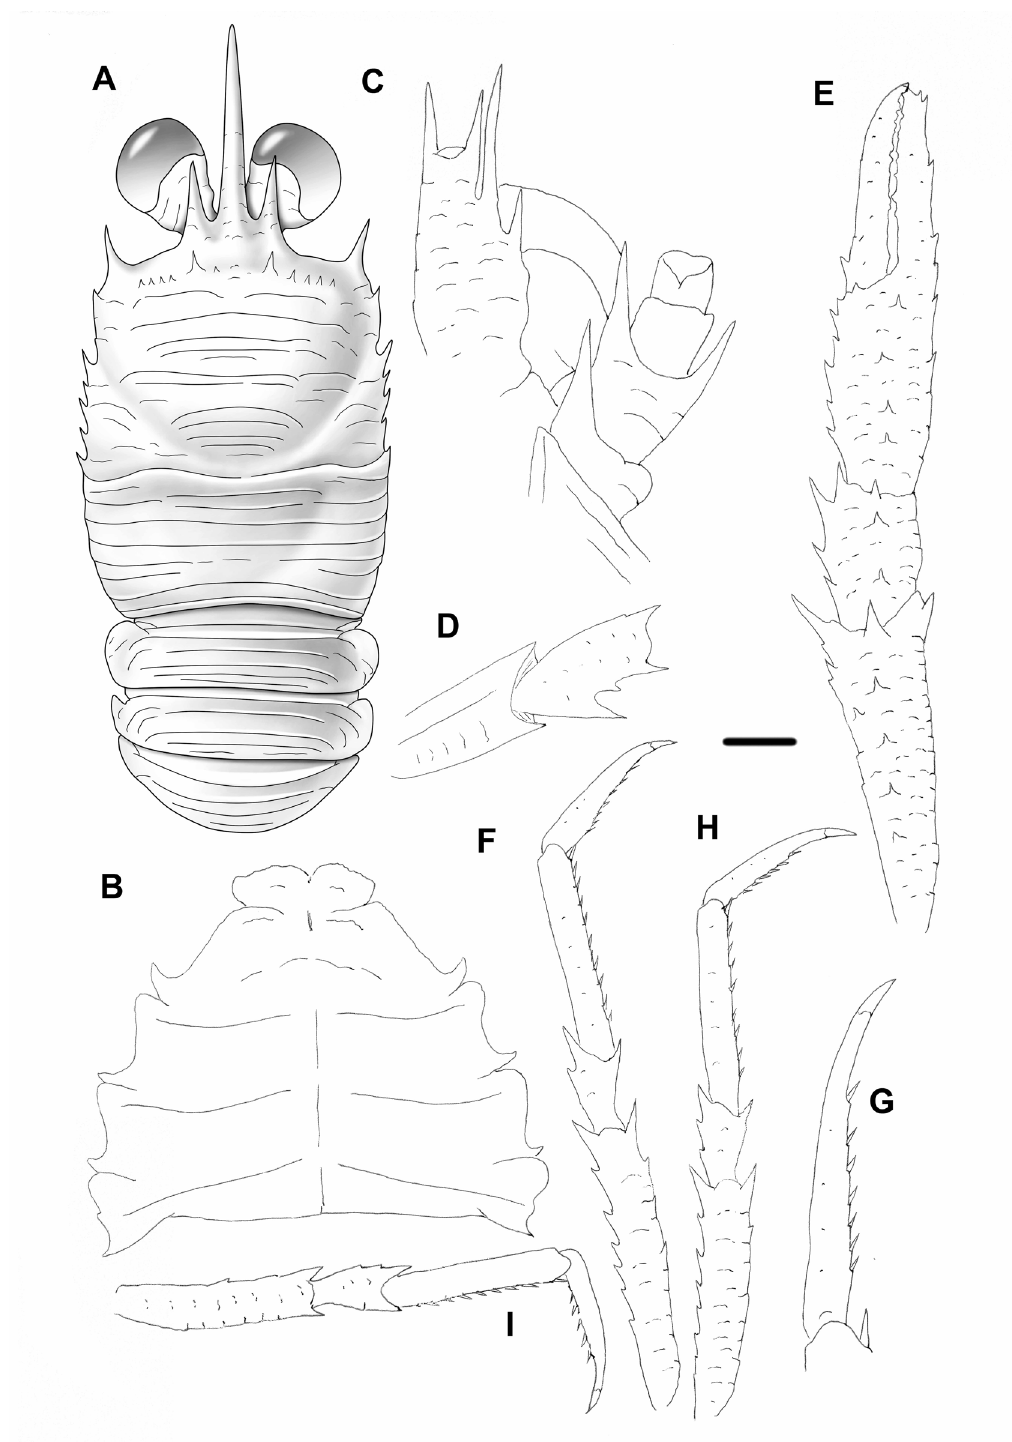
Fig. 2. Munida austrina sp. nov., holotype, ♀, 4.6 mm (MNHN-IU-2014-13478), Mozambique. A . Carapace and abdomen, dorsal view. B . Sternal plastron. C . Cephalic region, showing antennular and antennal peduncles, ventral view. D . Right Mxp3, lateral view. E . Right P1, dorsal view. F . Right P2, lateral view. G . Dactylus of right P2, lateral view. H . Right P3, lateral view. I . Right P4, lateral view. Scale bar: A, E–F, H–I = 1.0 mm; B–D, G = 0.5